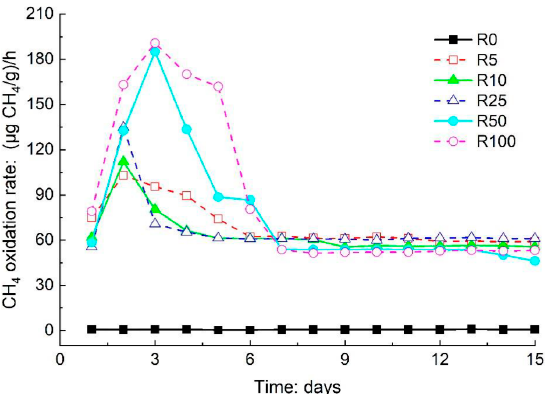
Figure 2. Methane oxidation rate of cover soil with different amounts of aged refuse versus time.